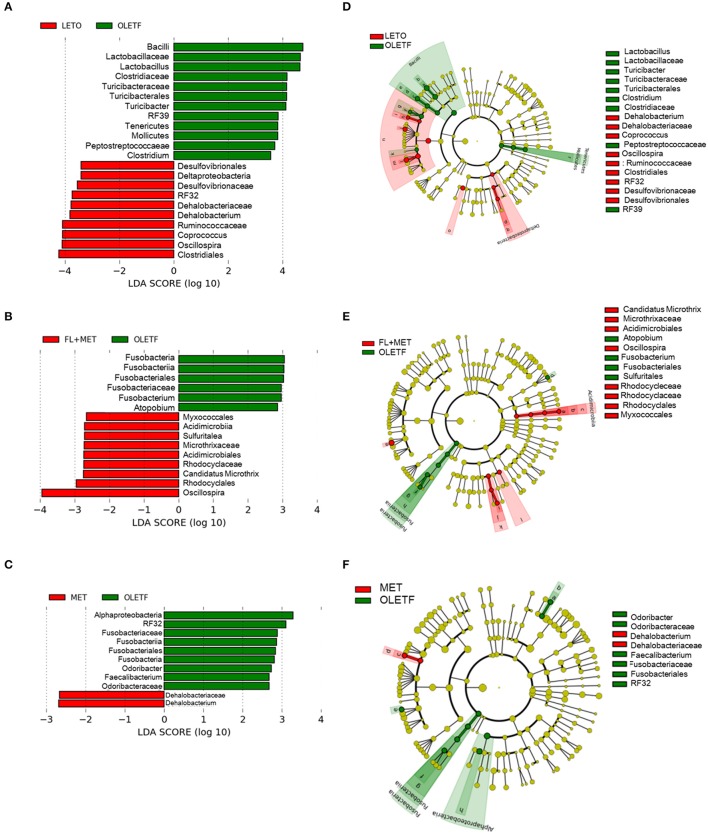
Inter-group variation in the relative abundances of gut microbial communities. Taxonomic comparison of the gut microbiota is demonstrated as follows: LETO vs. OLETF (A), FL+MET vs. OLETF (B), and MET vs. OLETF (C). Circular cladograms depicting the LEfSe results are as follows: LETO vs. OLETF (D), FL+MET vs. OLETF (E), and MET vs. OLETF (F). The alpha value for the factorial Kruskal-Wallis test is <0.05 and the threshold on the logarithmic LDA score for discriminative feature is >2.0.